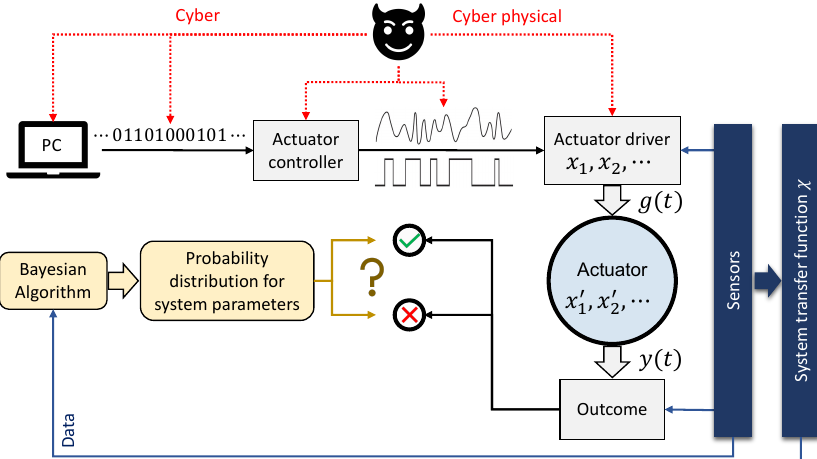
Figure 1. Schematic of the proposed Bayesian anomaly detection approach. A set of digital instruc- tions may be converted to an analog input g ( t ) driving a linear or nonlinear actuator. Parameters x (cid:48) ( x i ), i = 1,2, . . . describe the actuator (actuator input). An array of sensors measure the input-output relation and generate a transfer function χ , which is utilized as a model by the Bayesian algorithm. The model and the outcome data y ( t ) are employed by the Bayesian algorithm to generate prob- ability distributions for the parameters involved. Such an analysis has the potential to detect an adversarial influence on the outcome from either a cyber or a cyber-physical attack (an example being a modification of the G-code in 3D printing